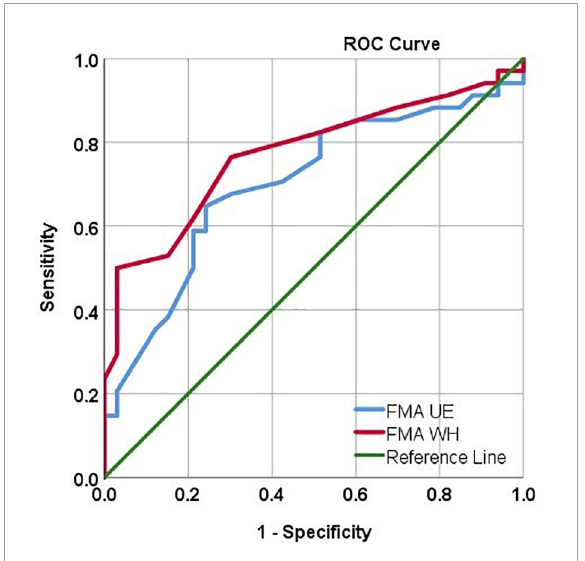
FIGURE4 ROC curve analysis depicting the FMA UE and FMAW/H values in identifying MEP responders. FMA UE produced AUC = 0.70, sensitivity = 67.6%, specificity = 69.7% in identifying MEP responders. FMA W/H produced AUC = 0.77, sensitivity = 76.5%, specificity = 69.7% in identifying MEP